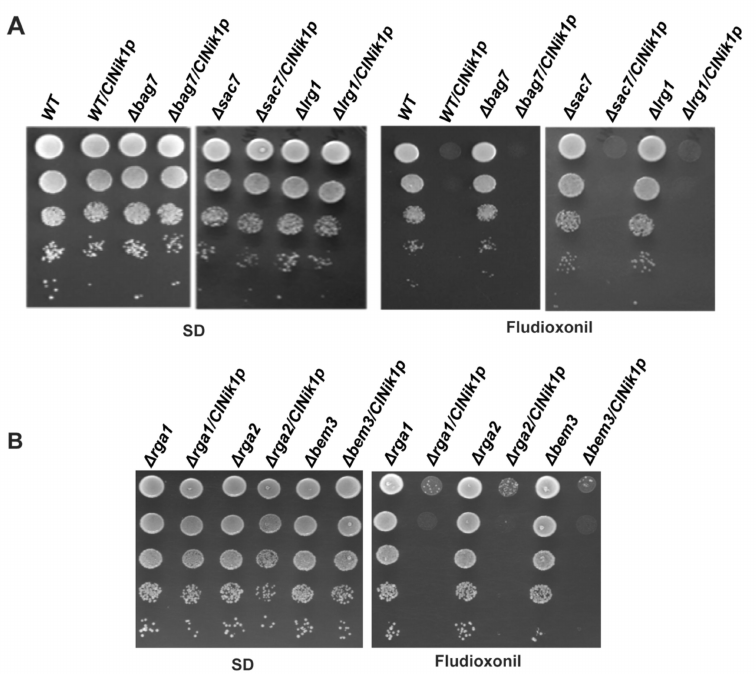
Figure 2. Fludioxonil sensitivity of S. cerevisiae strains having a deletion in different Rho1 GAP ( A ) and Cdc42 GAP ( B ) by dilution spotting. Log phase cultures of different deletion mutants having pClNik1 were spotted on SD plate with or without 25 µ g/mL fludioxonil and incubated for two days at 28 ◦ C. Representative figures from three independent experiments were